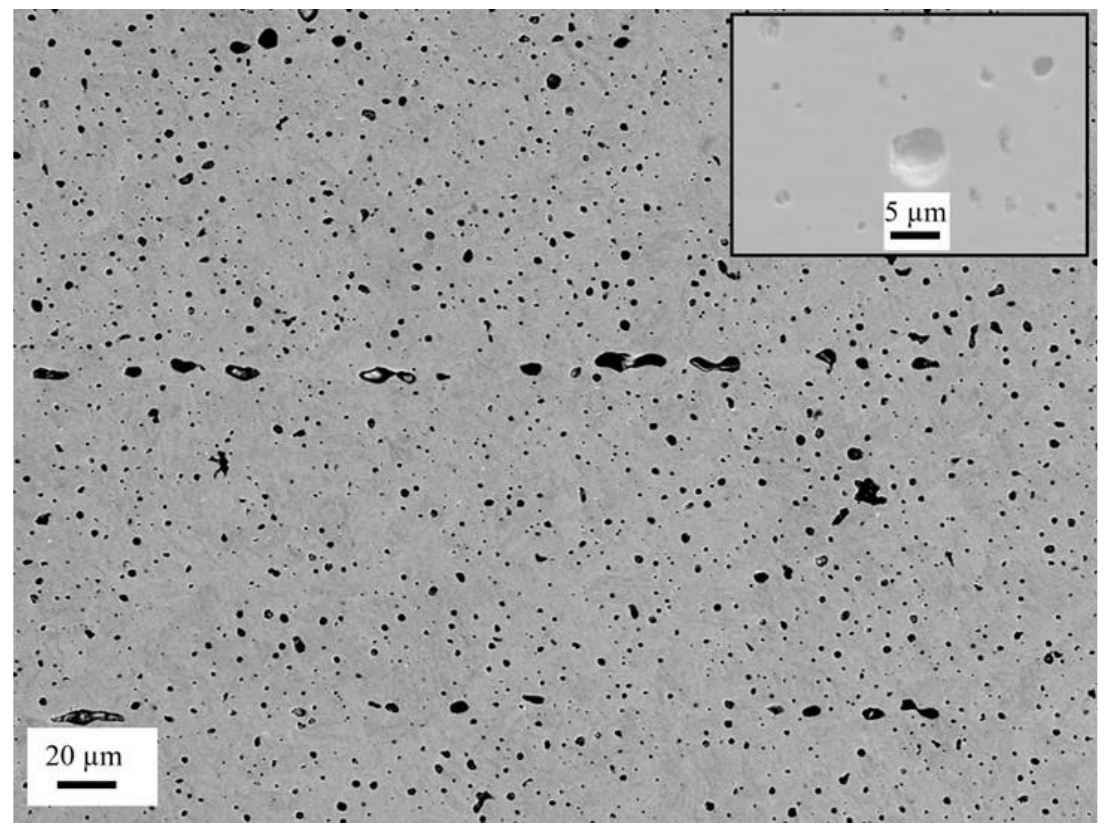
Figure 10. An example of a back-scattered electron image showing pores with variable sizes. The insert is a higher magnification secondary electron image to illustrate the pore structures.